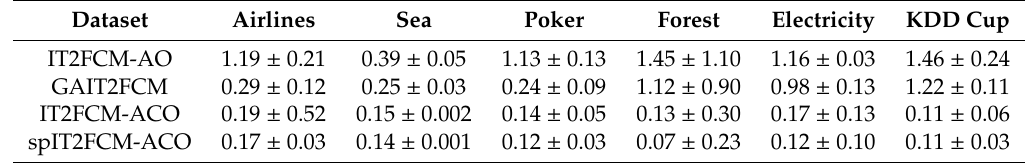
Table 6. Evaluation of ER.